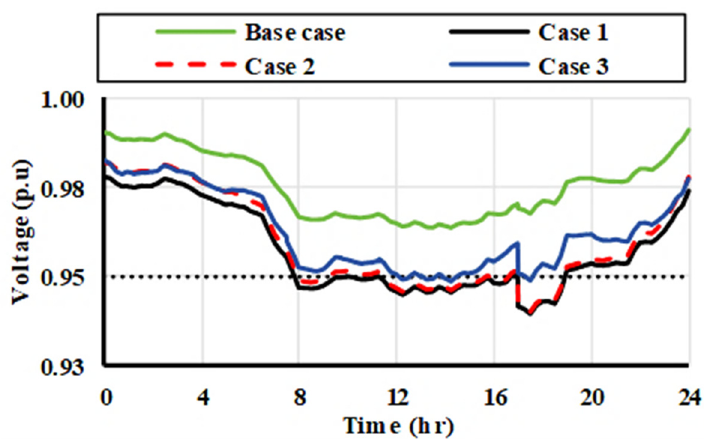
Figure 16. Voltage profile at bus 114.